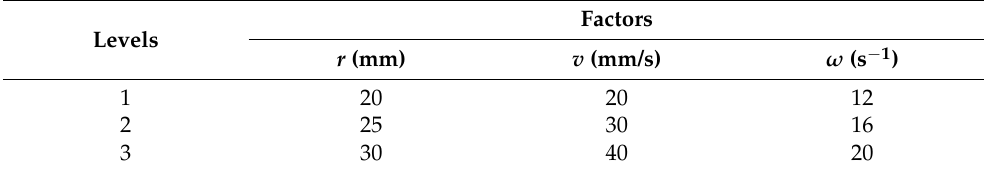
Table 6. Test factor levels.